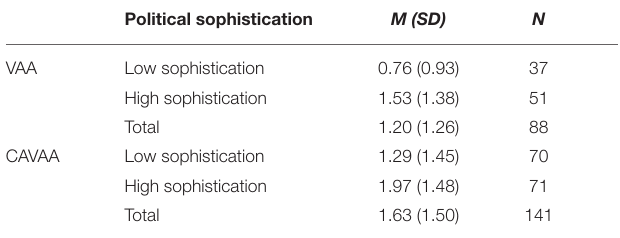
TABLE 2 | Means and Standard Deviations of voting intention (ranging from 1 – a low voting intention to 7 – a high voting intention) in each condition.